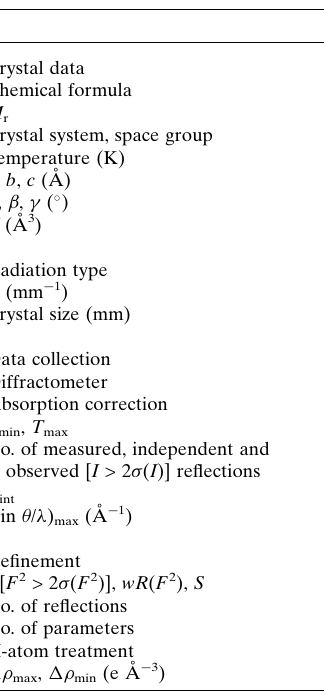
Table 4 Experimental details.